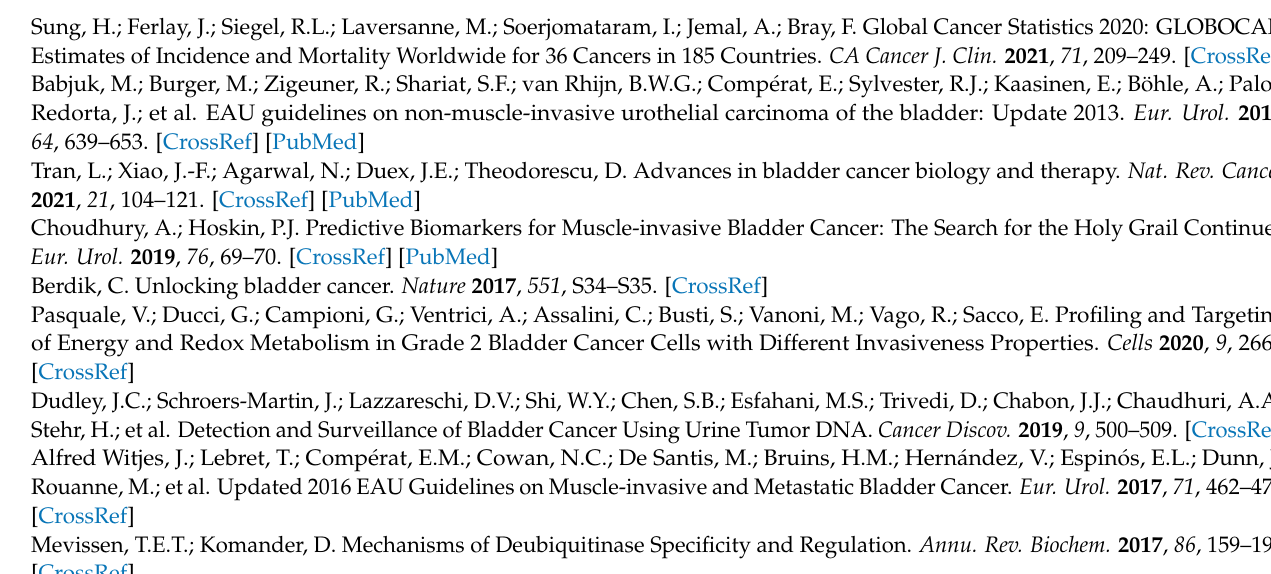
pathway; Figure S2: SC79 reverses the effects of UCHL5 silencing in bladder cancer cells; Table S1: Primer sequences for qRT-PCR; Table S2: Primary antibodies for Western Blot and immunohisto- chemical; Table S3: Secondary antibodies for Western Blot and